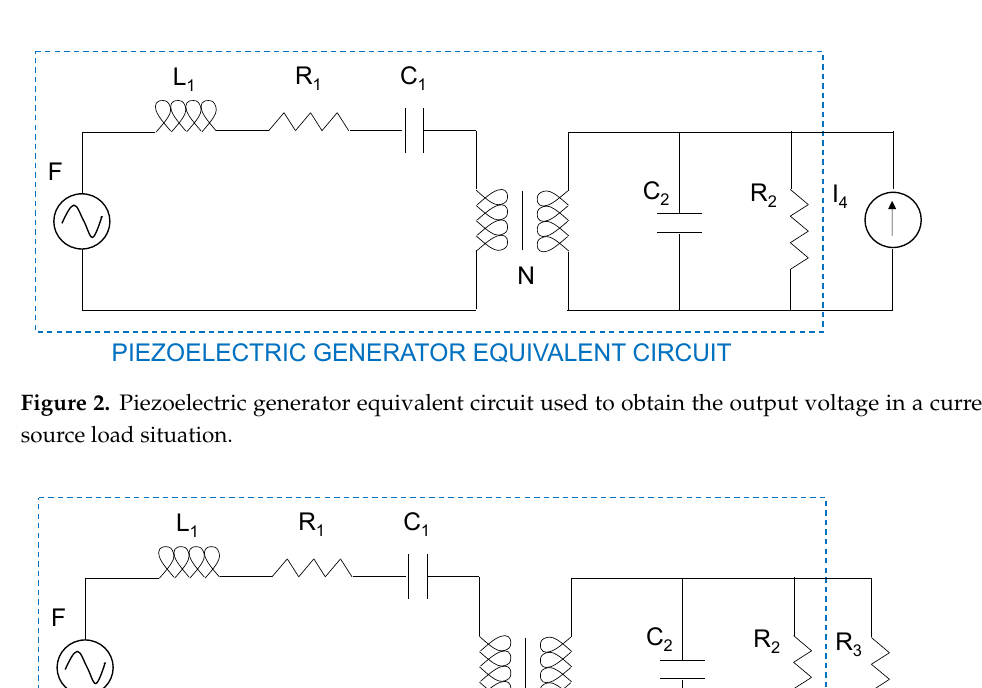
Figure 2. Piezoelectric generator equivalent circuit used to obtain the output voltage in a current source load situation.